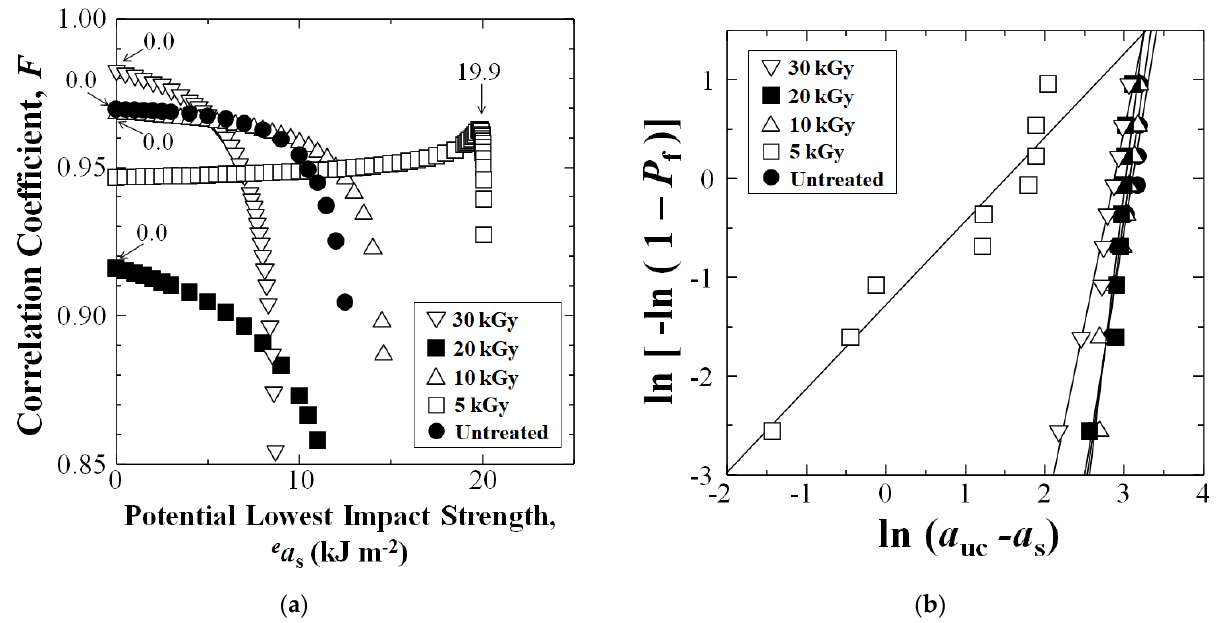
Figure 7. Iteration of potential lowest imact strength ( e a s ) to obtain statistically lowest impact strength a s ( a uc at P f = 0) when correlation coefficient F reaches the maximum (arrows) ( a ); and linear relationships between ln( a uc − a s ) and ln[-ln(1 − P f )] from the 3-dimensional Weibull calculation ( b ). Average a uc and standard deviations (in brackets) for untreated, 5, 10, 20, and 30 kGy HLEBI data sets are 20.4 (4.1), 23.8 (2.9), 20.0 (3.6), 19.1 (2.6), and 16.1 (3.9) kJ m − 2 ,